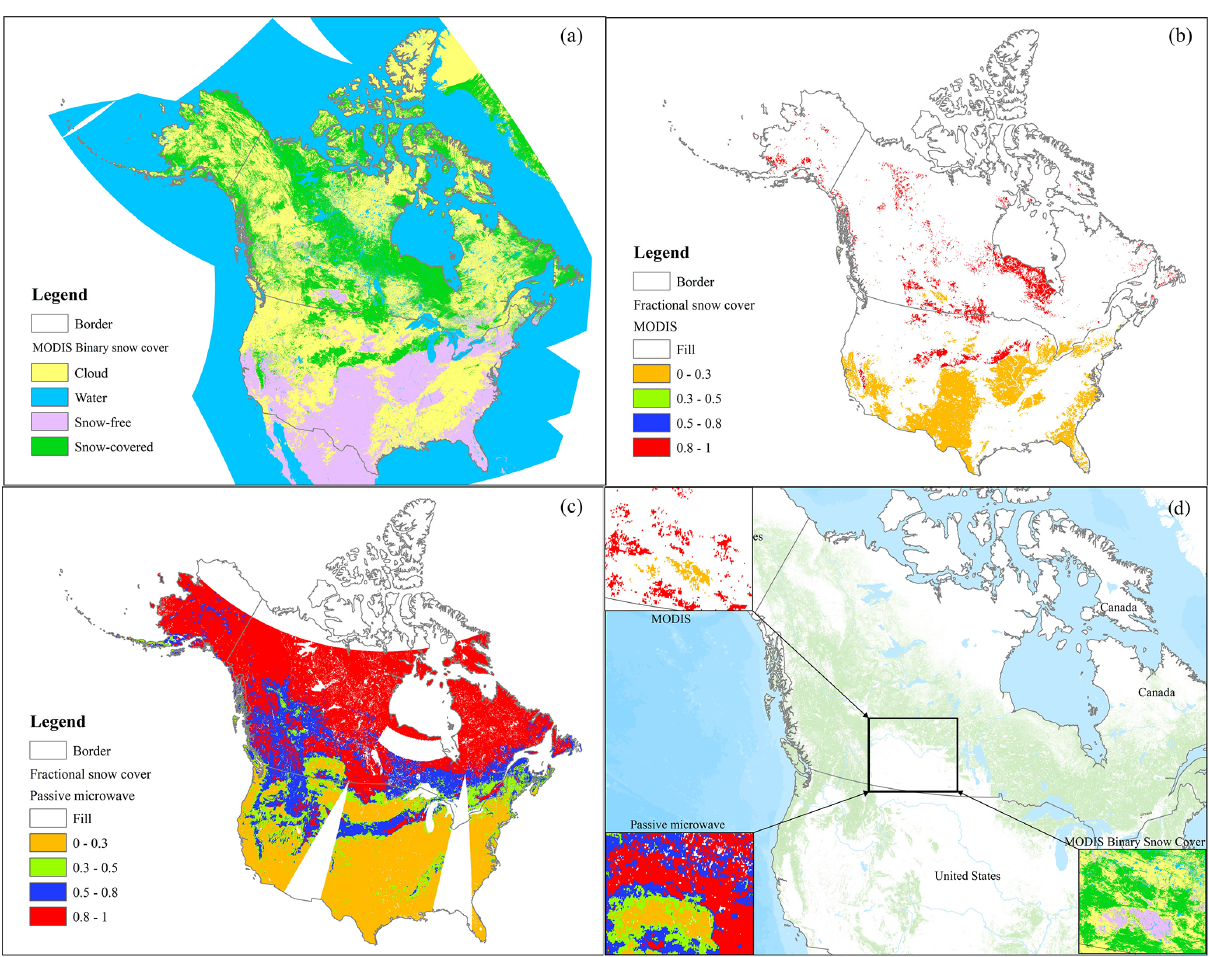
Figure 9. Comparison of our estimated fractional snow cover ( c ; 6.25km) with the reference MODIS fractional snow cover ( b ; 6.25km) with respect to the MODIS composite binary snow cover products ( a ; 500m) and a comparison example in the central Canadian area (d) on 27 February 2017 (2017058) (cf. the results in continuous value; Fig. S7 in the